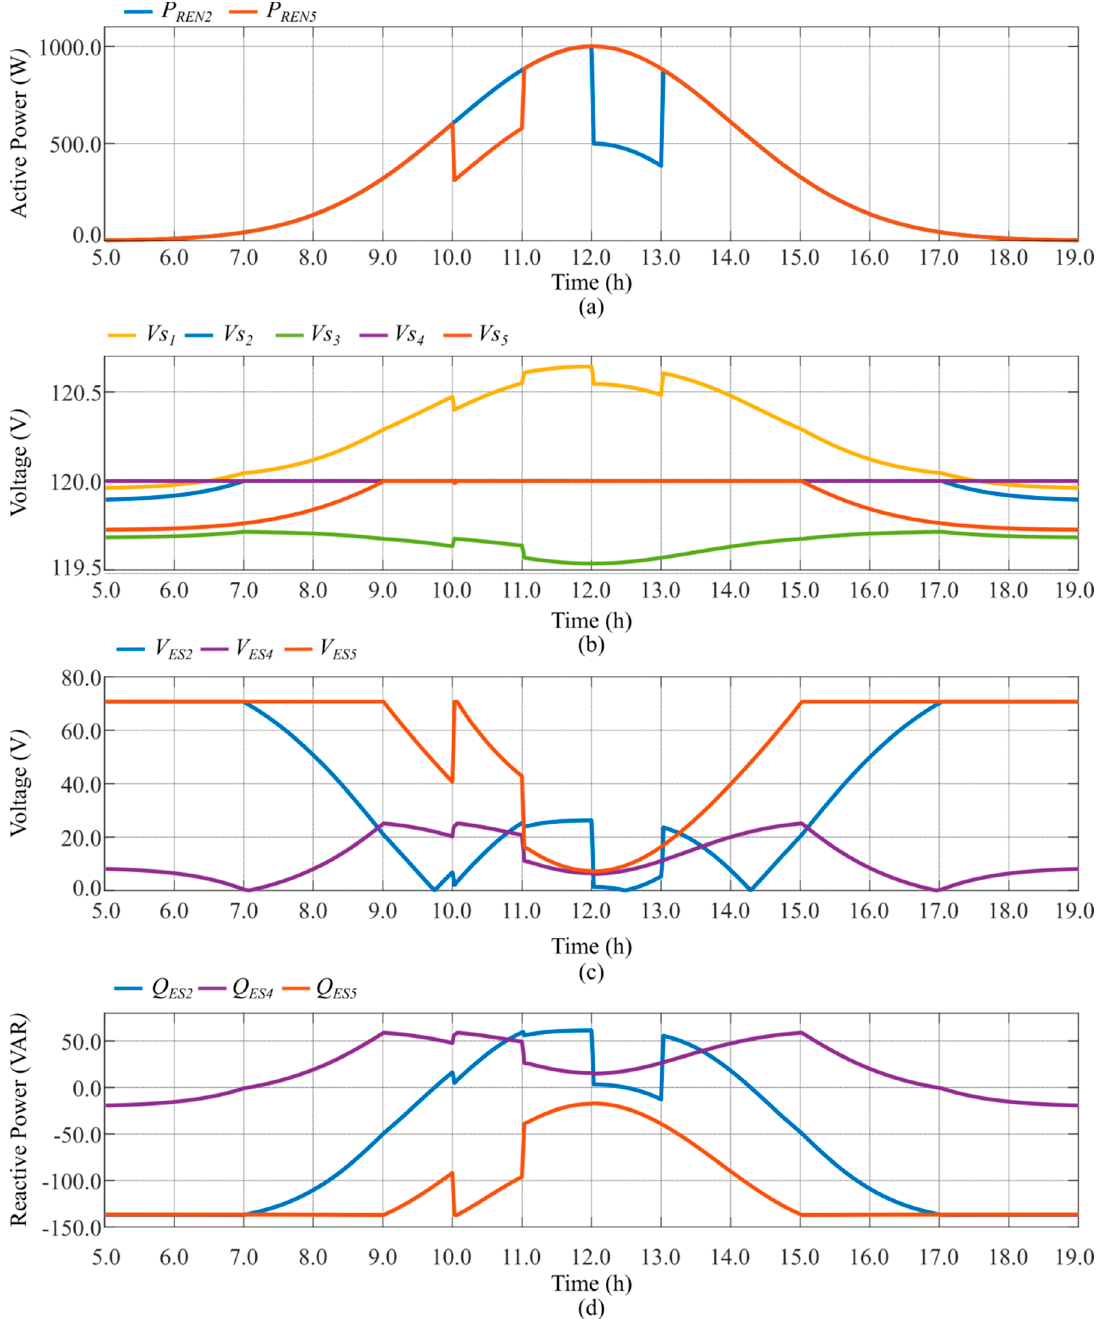
Figure 11. Quasi-stationary simulation model. ( a ) Active power delivered by RES, ( b ) Node voltages, ( c ) ESs voltages, and ( d ) ESs reactive power.